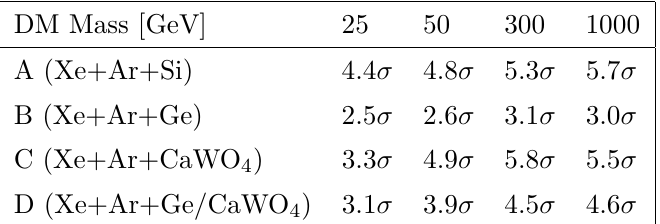
Table 3 . Maximum signi(cid:12)cance for discriminating Dirac and Majorana DM. Maximum value of the median discrimination signi(cid:12)cance achievable for a range of experimental ensembles and DM masses. These values correspond to the starred points in (cid:12)gures 1{4. Note that for ensembles